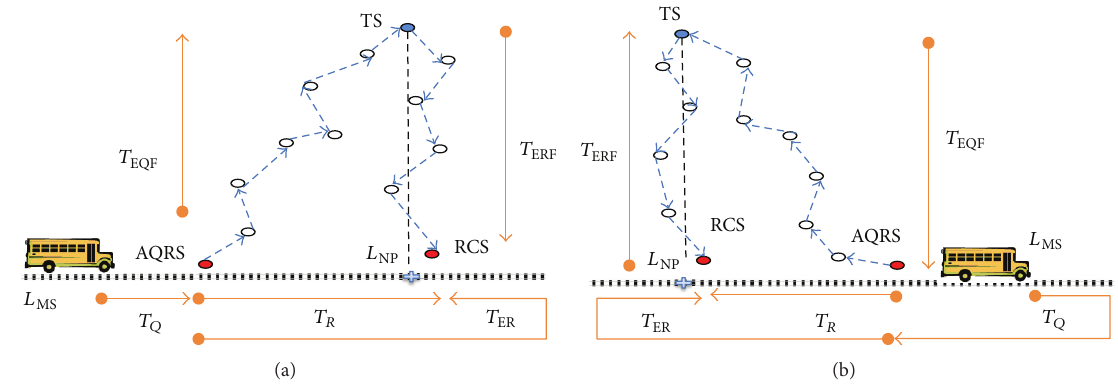
Figure 4: Optimum energy consuming schedule when MS moves in the direction of TS (a) and when it moves in the other direction (b).